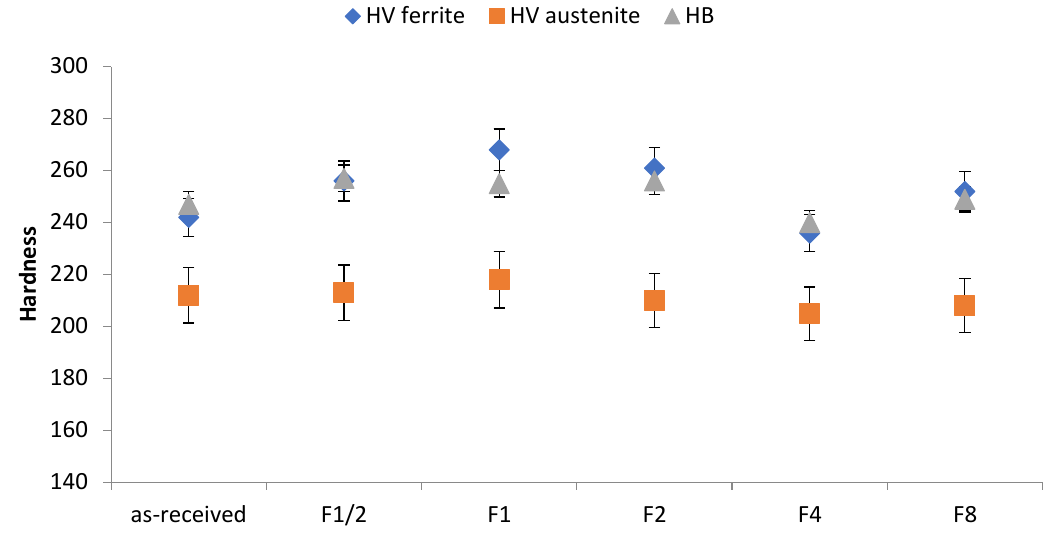
Figure 4. Hardness measurements for different annealing socking times.